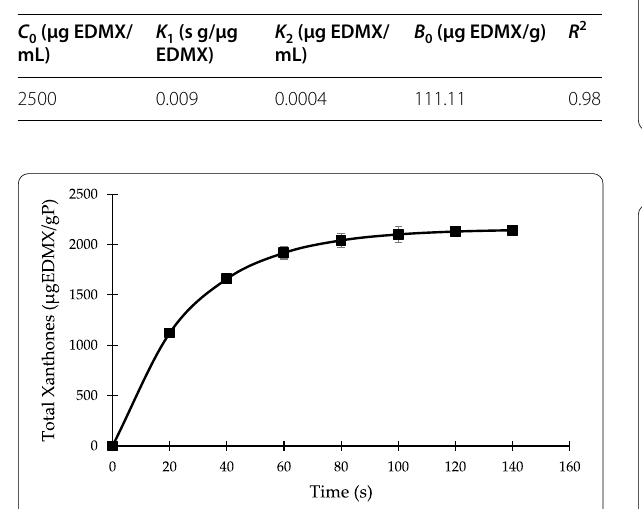
Fig. 2 Suitability of Peleg model for the kinetics of microwave-assisted extraction of xanthones from S. longepedunculata